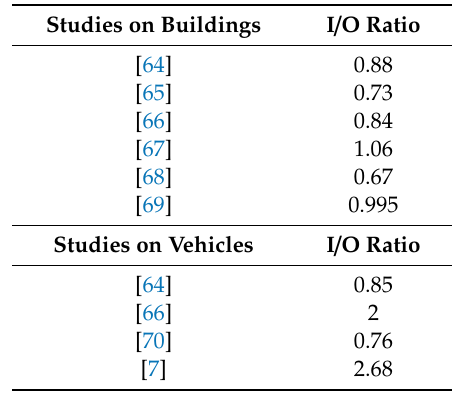
Table 1. Microenvironmental adjustment factors for PM